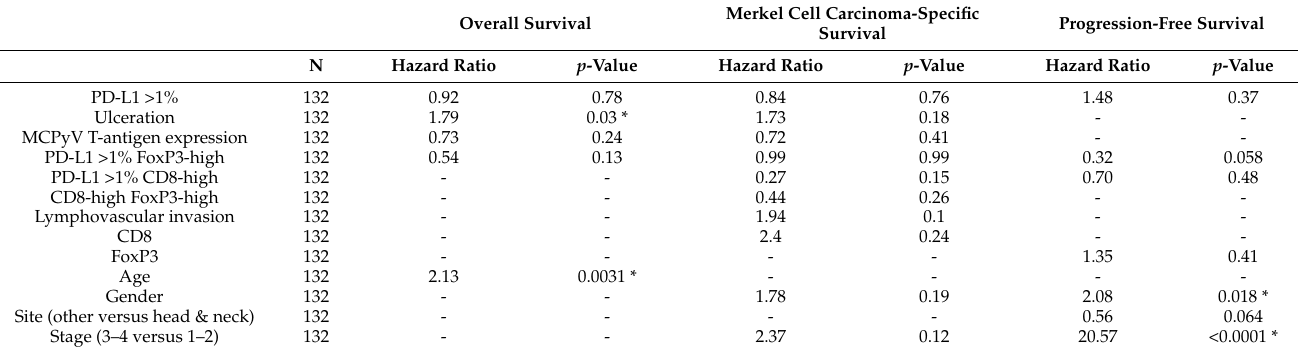
Table 3. Multivariate Cox proportional hazards